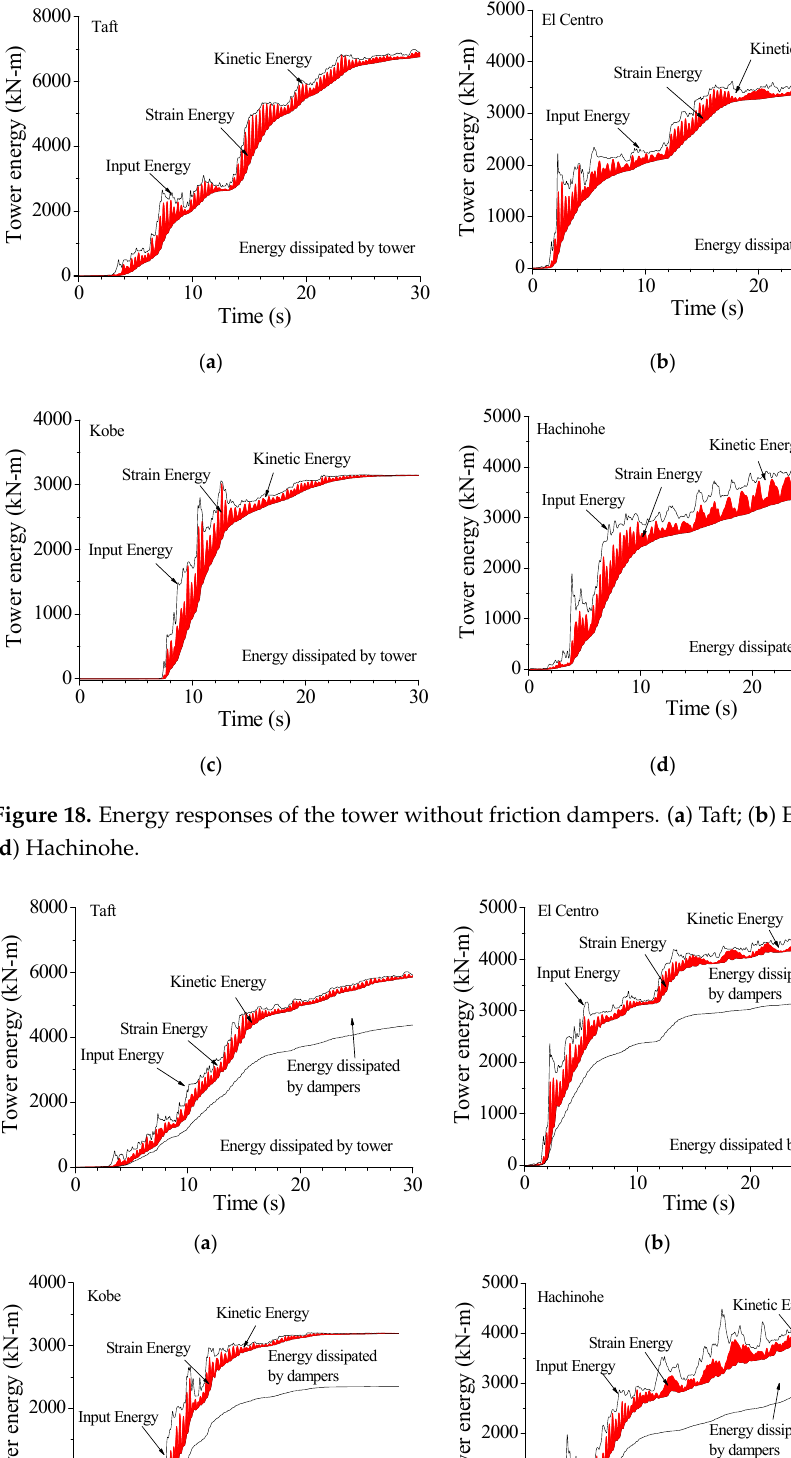
( c ) Figure 20. Variation of energy responses with damper stiffness. ( a ) Tower energy; ( b ) Energy by structural damping; ( c ) Energy by damper. 8. Concluding Remarks The validity of the proposed control approach for TV transmission towers by SMA dampers is examined in detail. The PSD properties and energy responses of the tower are compared with those of the uncontrolled tower. The results indicate that SMA dampers, with optimal parameters, can be used in the control of TV transmission towers disturbed by earthquakes.